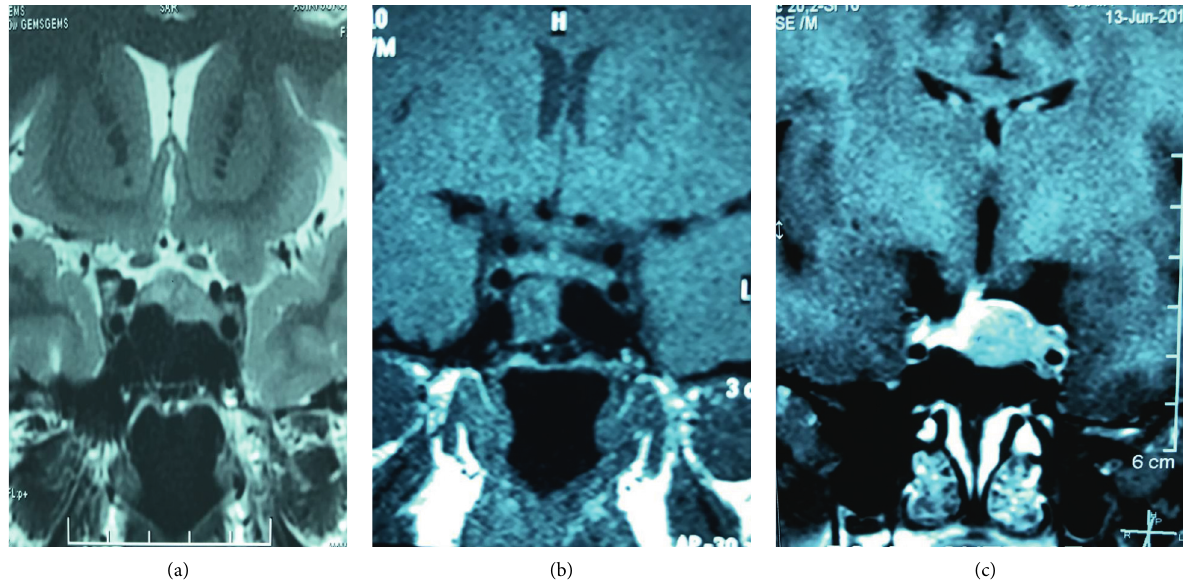
Figure 1: (a) 9.6mm × 6.7mm nonenhancing lesion in the pituitary fossa, (b) postsurgical changes with no evidence of adenoma, and (c) a 1.3 × 1.2 × 1.1cm recurrent lesion in the left pituitary with left cavernous sinus